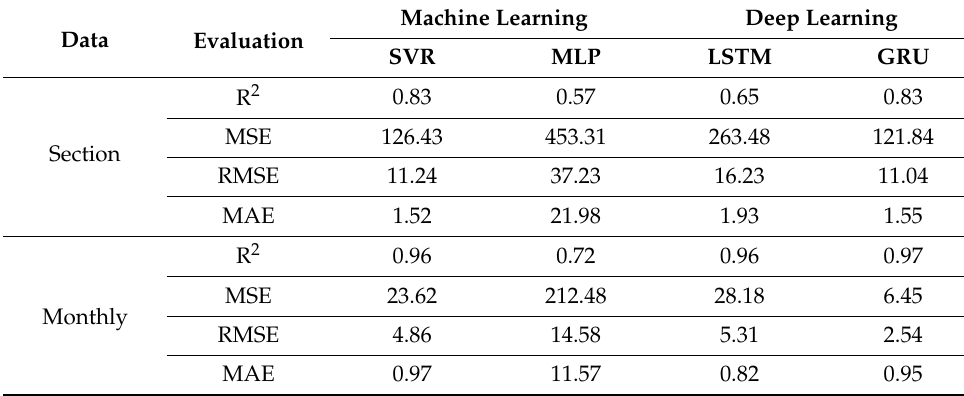
Table 7. Overall Results of Proposed Model based on Section and Monthly